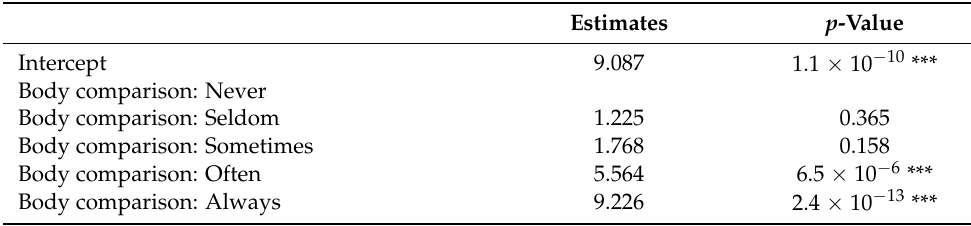
Table 10. Linear regression looking for a link between EDI-BD score and frequency of comparing one’s own physical appearance to that of people followed on social